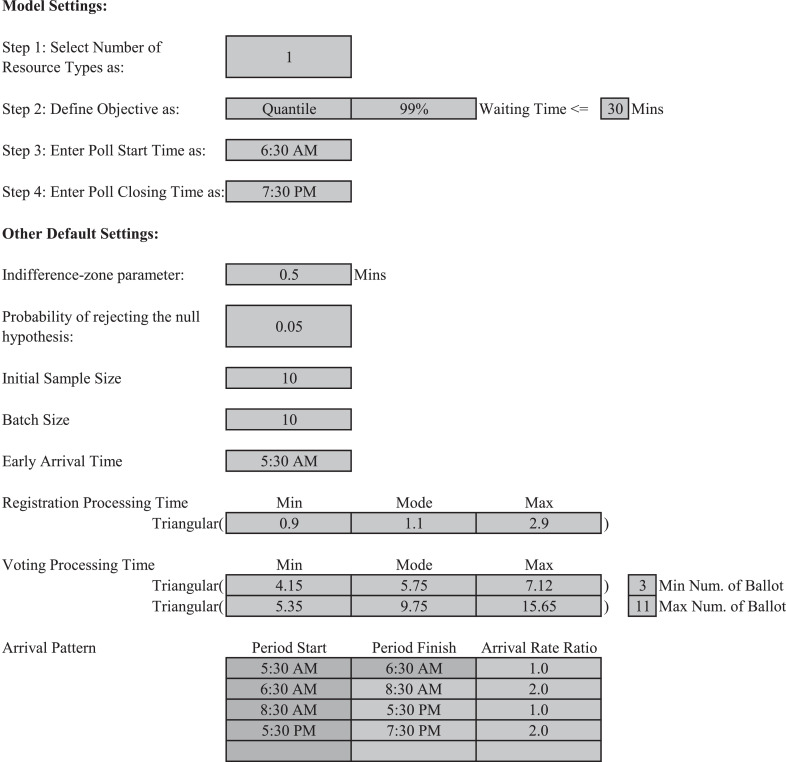
Parameter entry interface of IZGBS election resource allocation software.